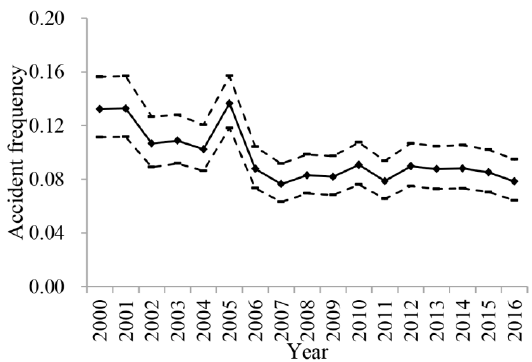
Figure 2. Uncertain time series of the vessel traffic accident frequency.